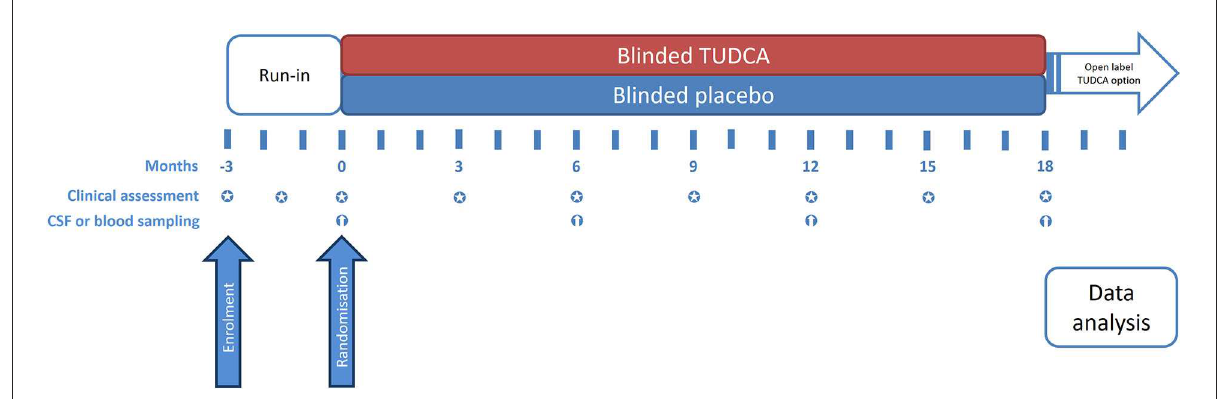
FIGURE2 Timeline of the study and visit